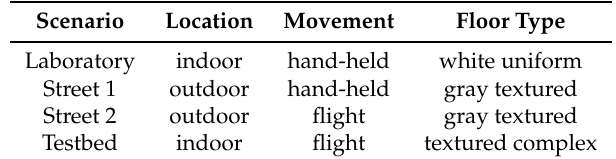
Table 1. Description of the testing scenarios.